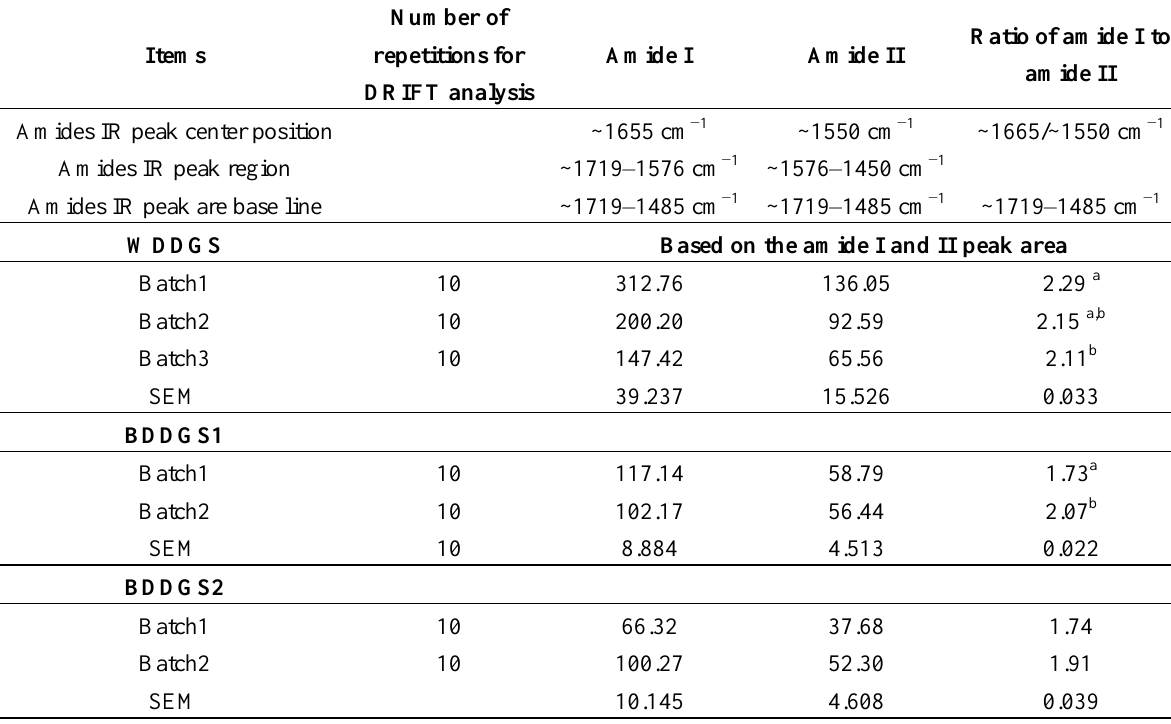
Table 2. Amide I and II and their ratios: Comparison of different batches within wheat DDGS and two types of blend DDGS using DRIFT molecular